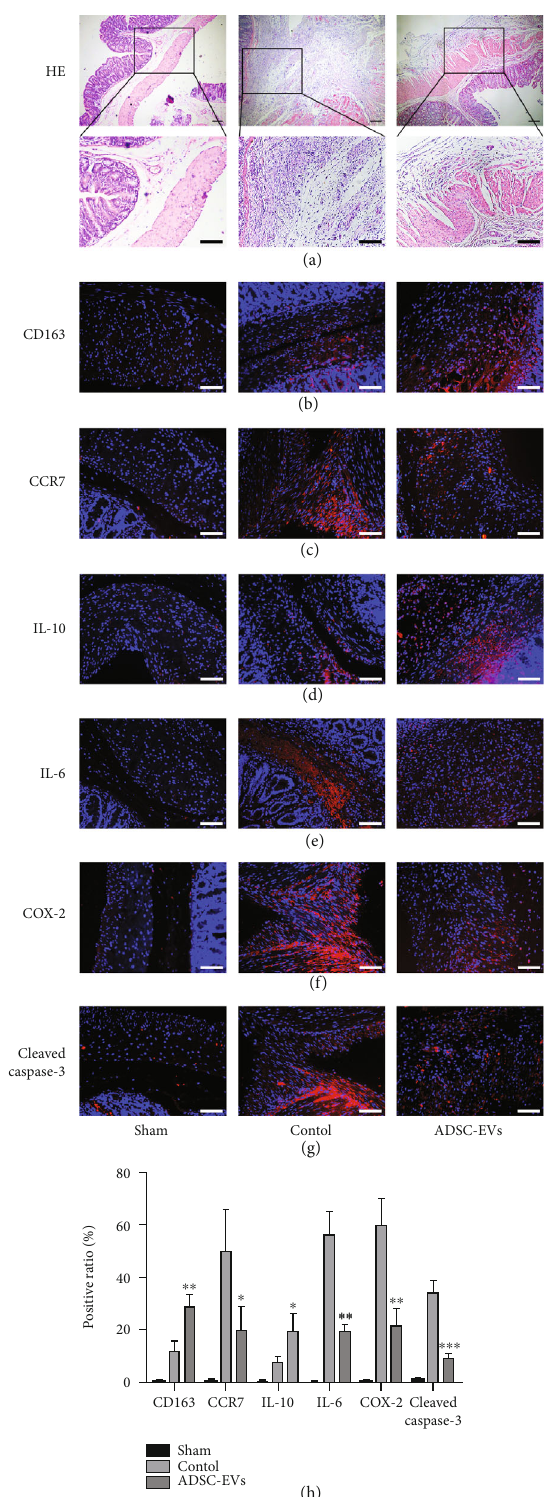
Figure 4: Impact of ADSC-EVs on peritoneal in fl ammation and apoptosis. (a) Hematoxylin-eosin staining of injured tissues (40x). Black tetragonum represents the accumulation of plasma cells, granulocytes, and macrophages (200x). (b – f) The expression of CD163 + , CCR7 + , IL-10 + , IL-6 + , and COX-2 + was evaluated at 4 days postsurgery by immuno fl uorescence assay. (g) Impact of ADSC-EVs on peritoneal apoptosis. Cellular expression of caspase 3 + at 4 days after surgery evaluated by immuno fl uorescence assay. (h) Positive cell ratio of in fl ammation-related factors and caspase 3+ cells at 4 days ( n = 6 ). Bars, 50 μ m. Data are represented as mean ± SD. ∗ , vs. control; ∗ P < 0 : 05, ∗∗ P < 0 : 01, and ∗∗∗ P < 0 : 001